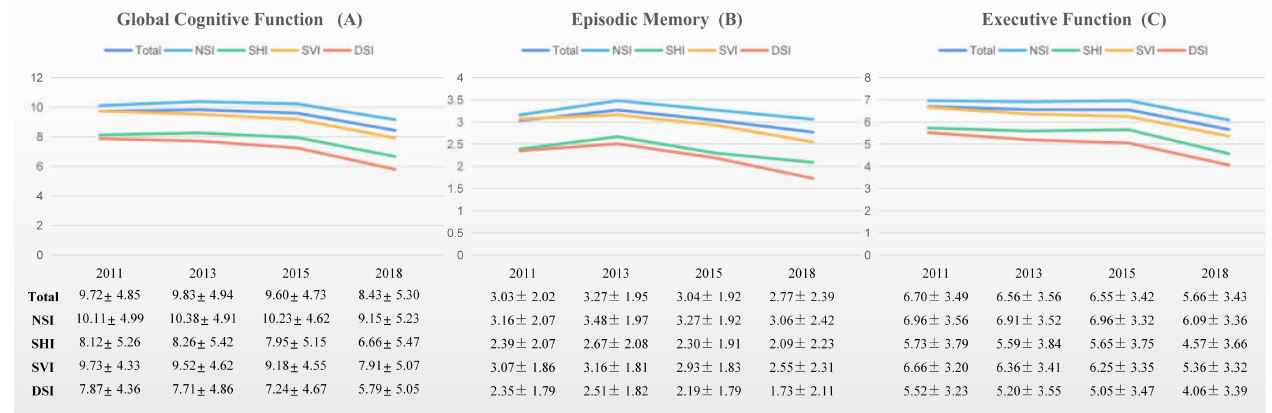
Figure 2. Graphic illustration of ( A ) Global cognition score by sensory impairment statuses over time, ( B ) Episodic memory score by sensory impairment statuses over time, ( C ) Executive function score by sensory impairment statuses over time. NSI: No sensory impairment group; SHI: Single hearing impairment group; SVI: Single vision impairment group; DSI: Dual sensory impairments group.